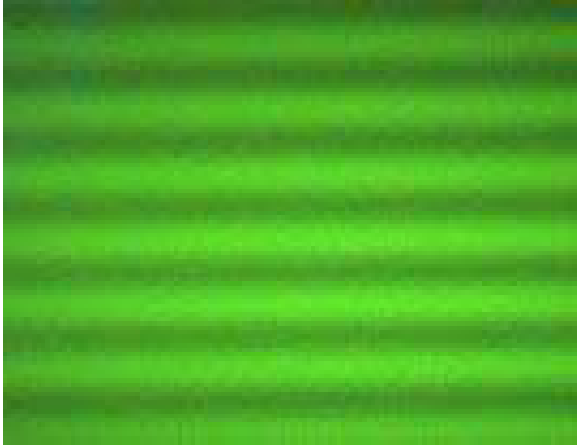
Figure 3. A fluorescence gradient/fringe pattern picture of an FITC sample. The interfringe distance corresponds to 17